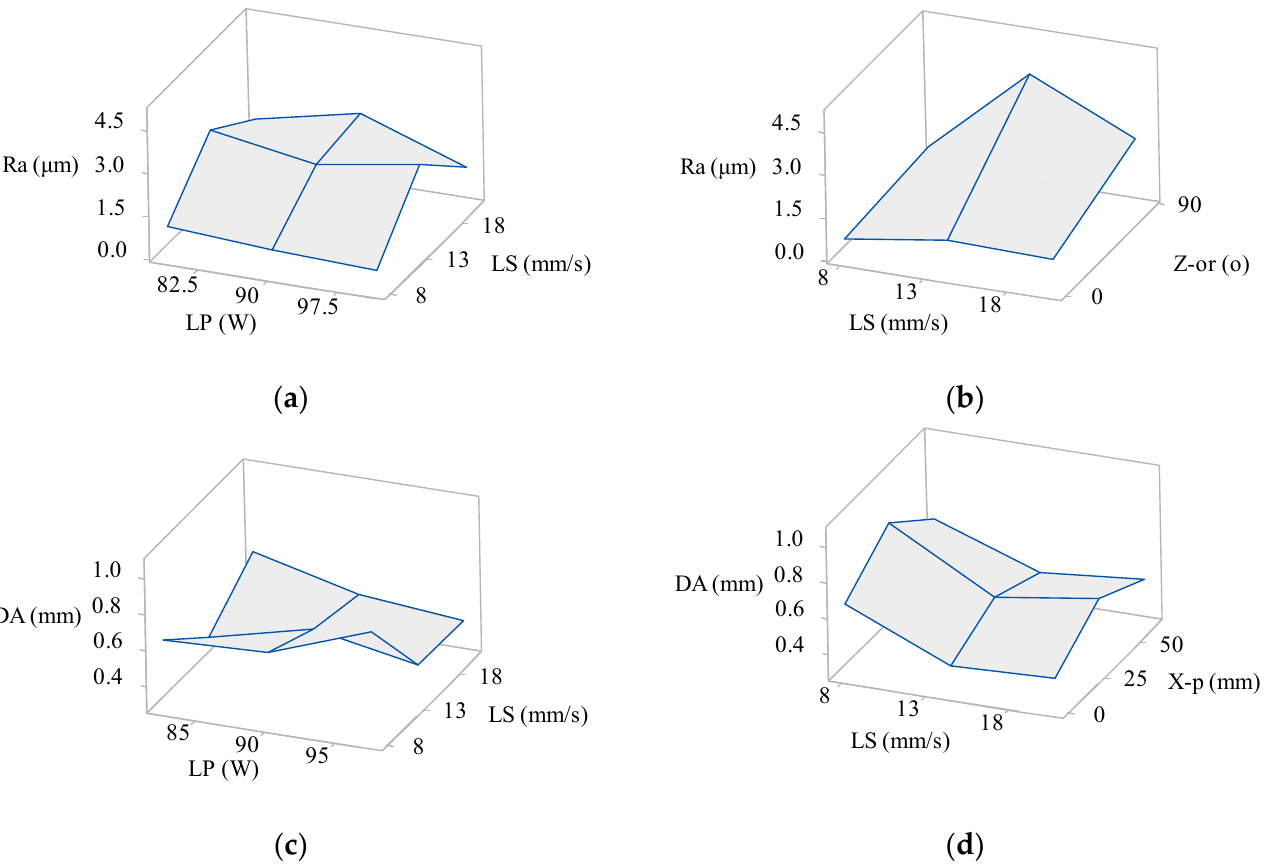
Figure 6. Surface plots: ( a ) Ra versus LP and LS, ( b ) Ra versus LS and Z-or, ( c ) DA versus LP and LS and ( d ) DA versus LS and X-p.